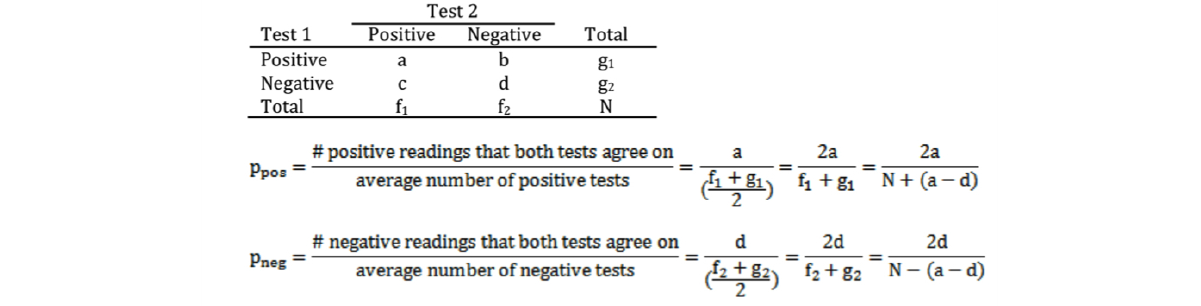
Figure 1. Calculation of positive and negative agreement between two